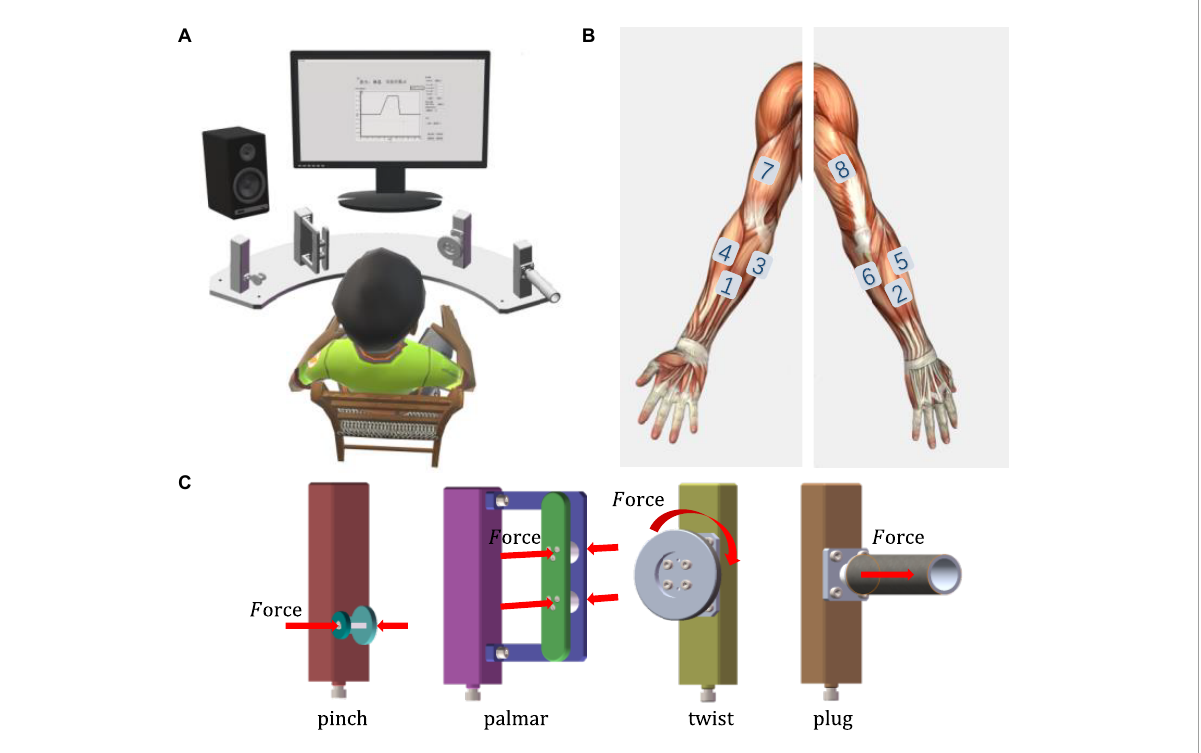
FIGURE1 Experimental setup for four natural grasping movements. (A) The experimental table with a screen in front. (B) EMG electrode setup on right arm (left: front, right: back). (C) Force sensor measurement